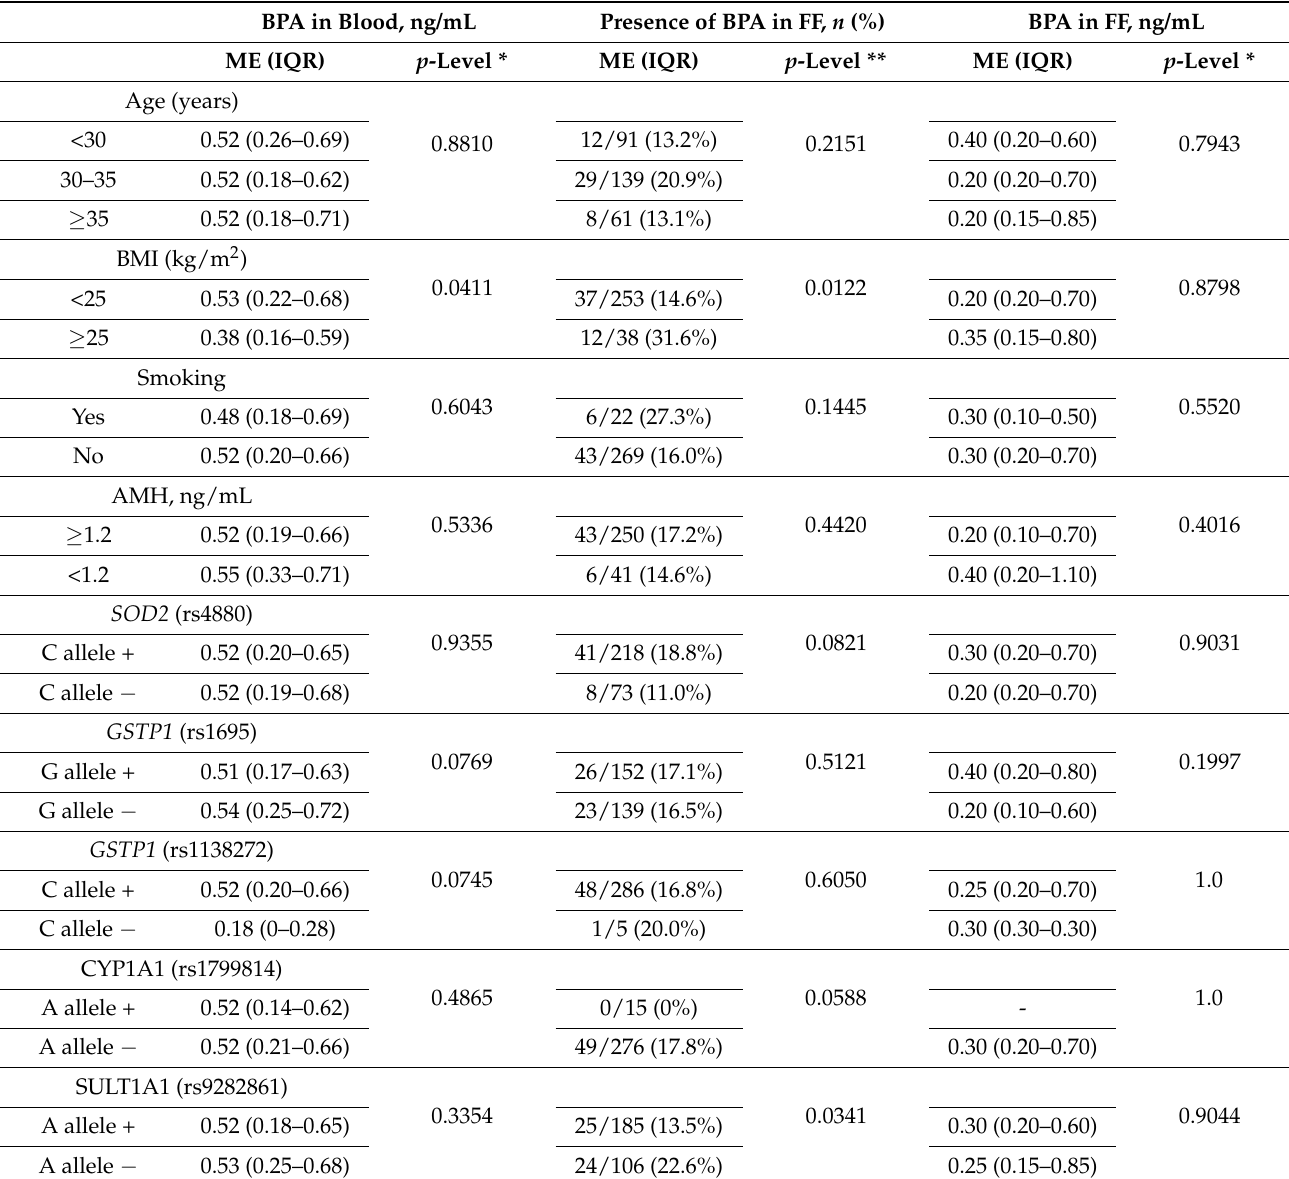
Table 2. The concentration of bisphenol A in the blood and FF of patients depending on main patient’s characteristics and polymorphisms of detoxification system